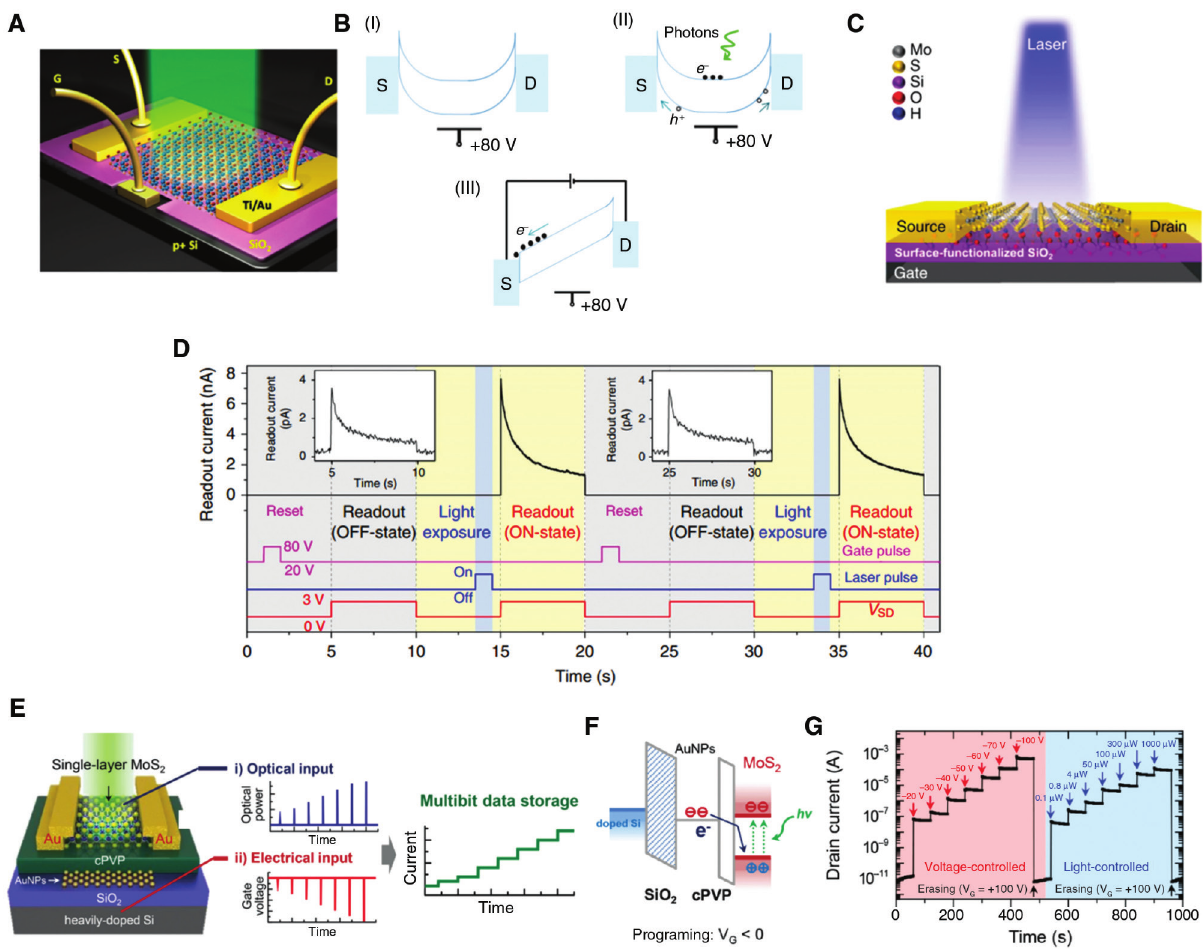
Figure 3: Three-terminal memristor in a FG-FET configuration. (A) Schematic of a CIS-based photonic memristor. (B) Energy band diagram at (I) initial state, (II) SET process under light illumination, and (III) read-out process. (A, B) Reproduced with permission [35]. Copyright 2015, American Chemical Society. (C) Schematic of the